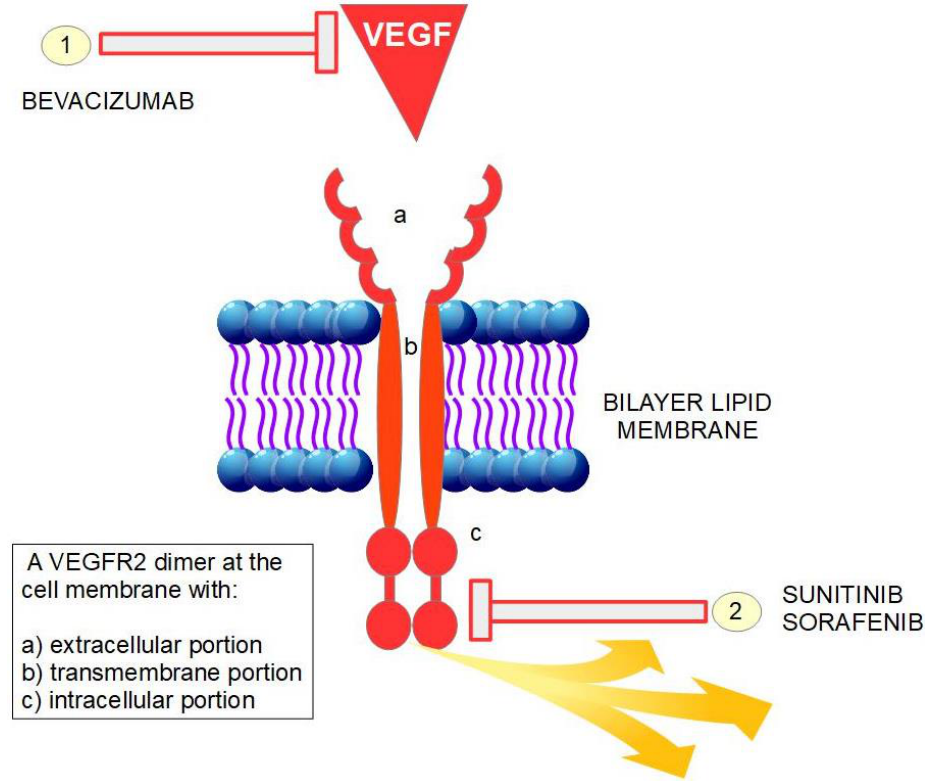
Figure 1. Two di ff erent mechanisms of anti-angiogenic Figure 1. Two different mechanisms of anti-angiogenic therapy.